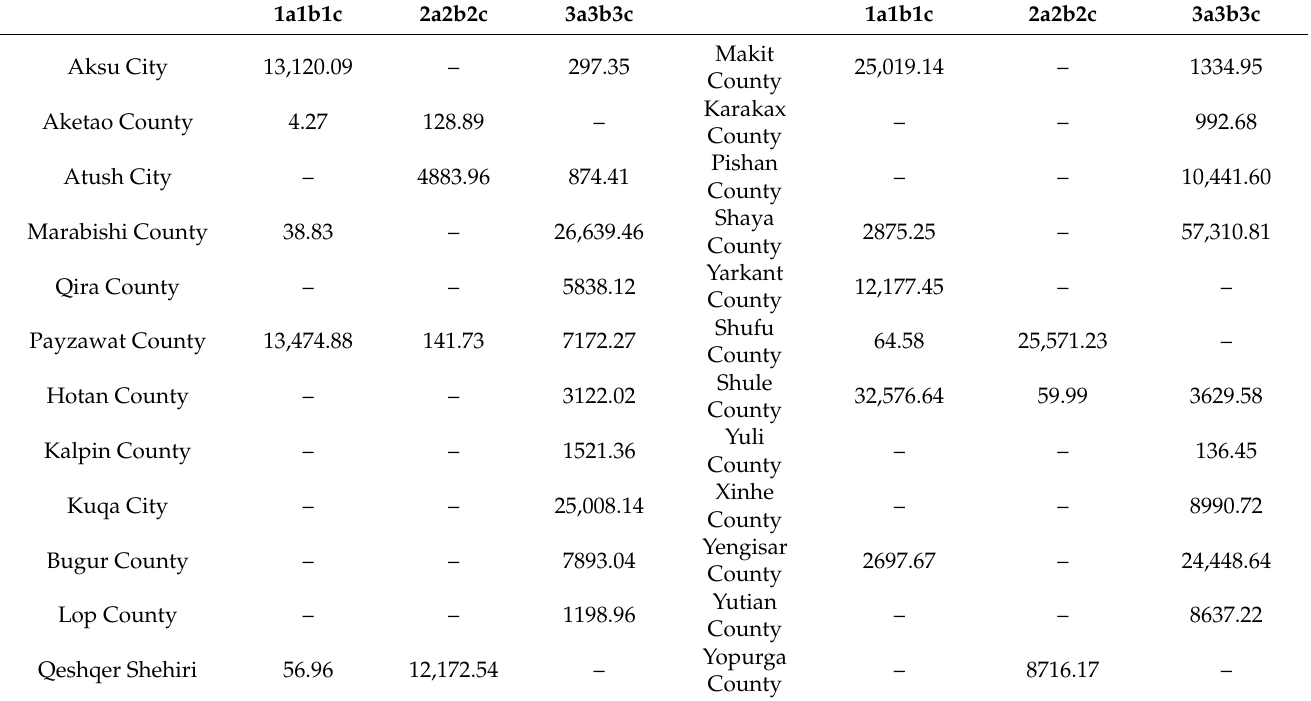
Table 2. Suitable for the three varieties of cotton seed production area (unit: